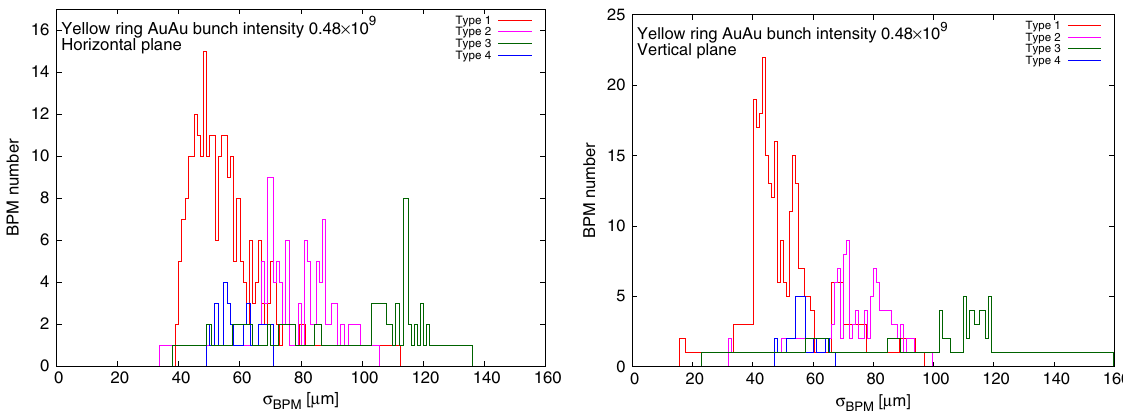
ring AuAu bunch intensity 0.48 × 10 9 Horizontal plane